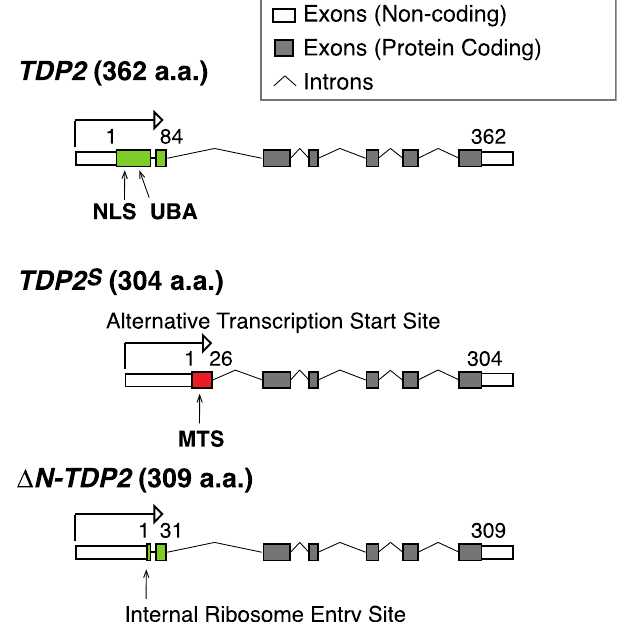
Figure 3. Scheme for the genomic organization of different TDP2 isoforms. The canonical TDP2 isoform encodes a 362 amino acid (a.a.) polypeptide with a nuclear localization sequence (NLS) and a ubiquitin binding domain (UBA) at its N-terminus (green). A shorter isoform termed TDP2 S results from an alternative transcription start site, which contains a canonical cleavable mitochondrial targeting sequence (MTS) (red), a unique feature among different isoforms of TDP2 [49]. A recently described ∆ N-TDP2 isoform (309 a.a.), which results from a downstream alternative translation start site, lacks NLS, UBA, and MTS [50].